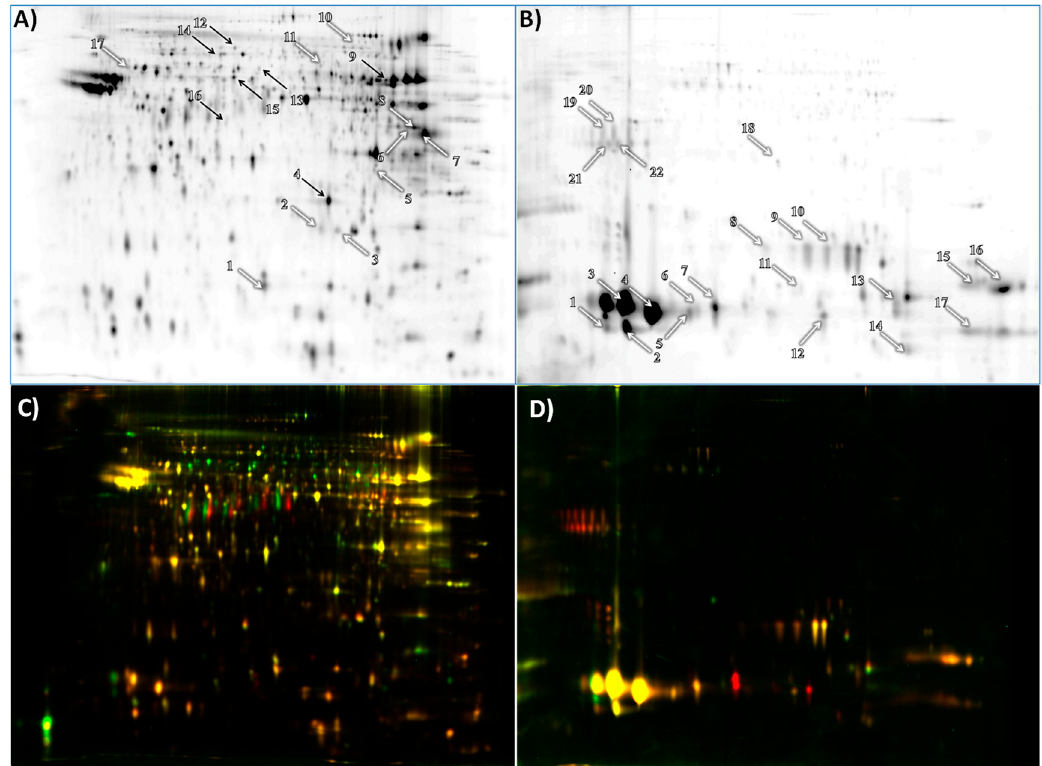
Figure 1. A representative 2D-DIGE gel showing the profile of bull thawed spermatozoa proteome ( A ) and supernatant of thawed sperm proteome ( B ). The overlay of spermatozoa ( C ) and supernatant ( D ) of semen collected from young and mature males. Mature samples were labeled with Cy5 (red) and young samples with Cy3 (green) dyes. White arrows mark protein spots increasing in abundance in adult bulls in comparison to young bulls, and black arrows mark protein spots decreasing in abundance in adult bulls in comparison to young bulls. Arrow numbers correspond to protein spot numbers presented in Tables 2 and 3. Table 2. Proteins changing in thawed spermatozoa of adult bulls in comparison to young bulls.